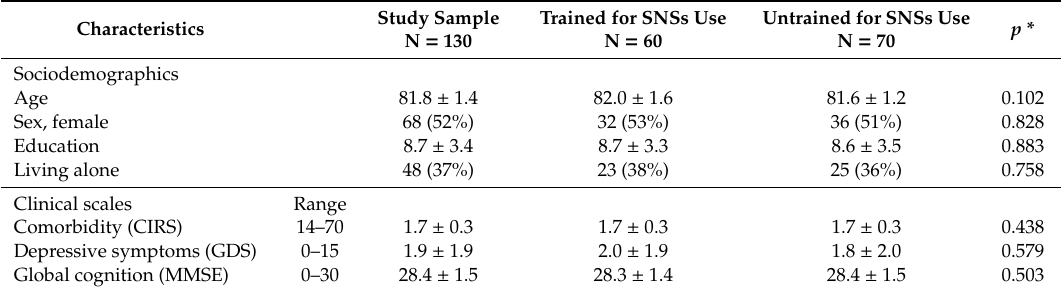
Table 1. Descriptive characteristics of the study population (N = 130) and comparisons between older adults trained and untrained for Social Networking Sites (SNSs) use.